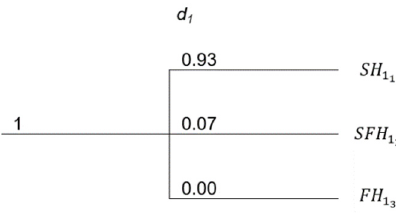
Figure 12. Event tree for activity (orders sent by the ship’s owner z 1 ).